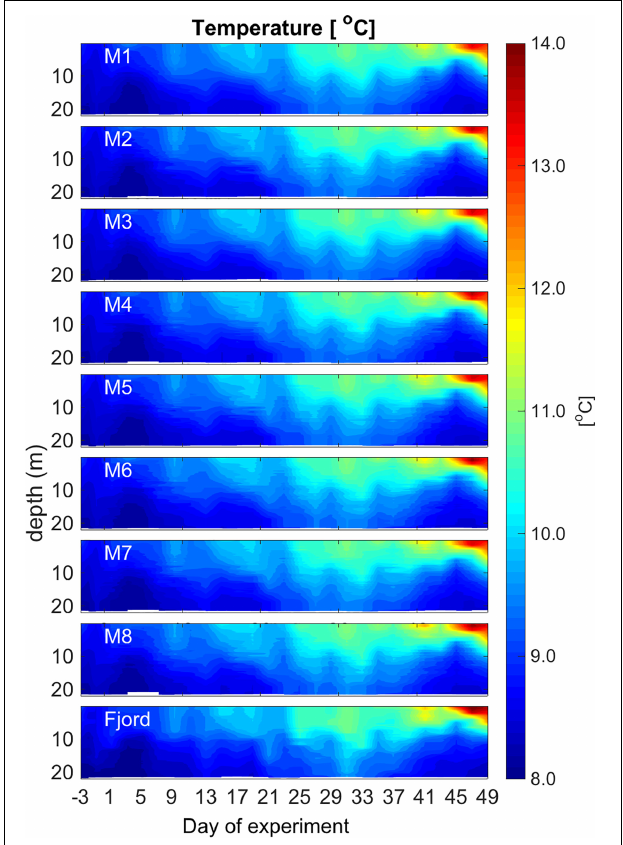
FIGURE 3 | Overview of the CTD – depth profiles of temperature ( ◦ C) over the course of the experiment. Figure created with MATLAB (version